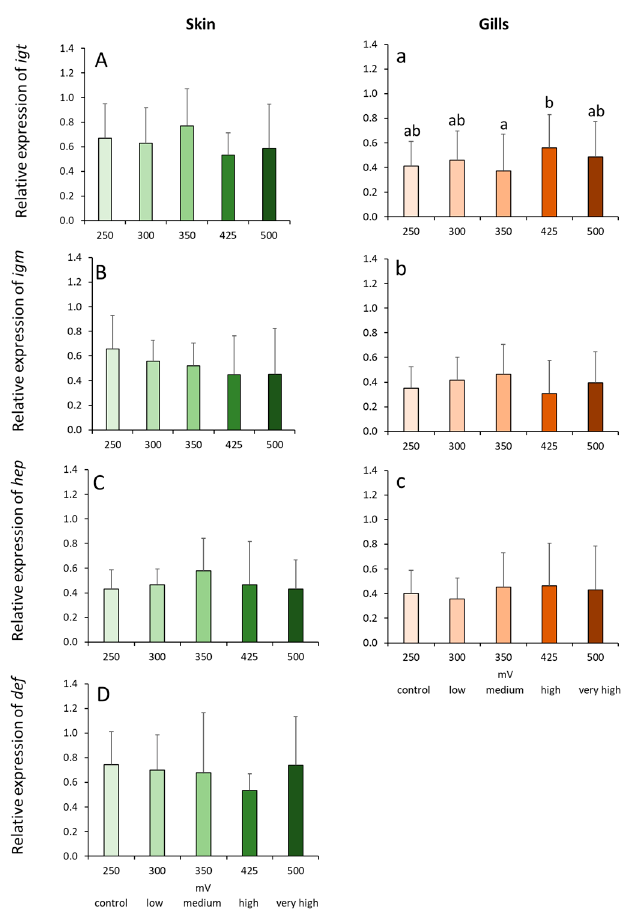
Figure 4. Relative expression of immunoglobulin and antimicrobial peptide genes in the skin ( A – D ) and gills ( a – c ) of Atlantic salmon exposed to varying ORP levels. Values are presented as mean and standard deviation of 6 individual fish per treatment group. Different letters denote significant differences between treatments at p < 0.05. Expression of def in the gills was almost negligible hence was not presented.